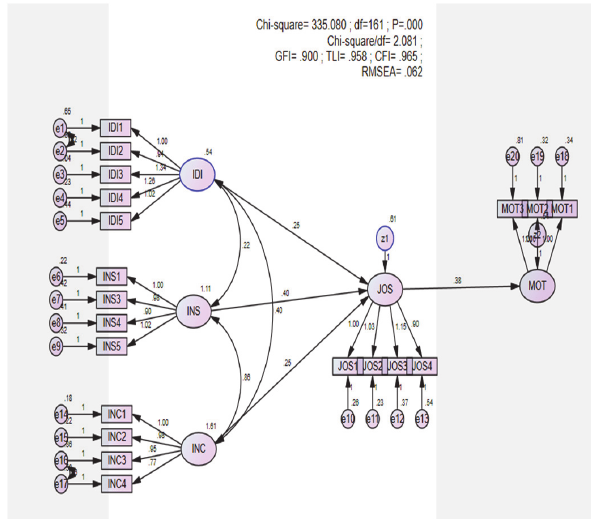
Fig. 3. SEM results for the standardized